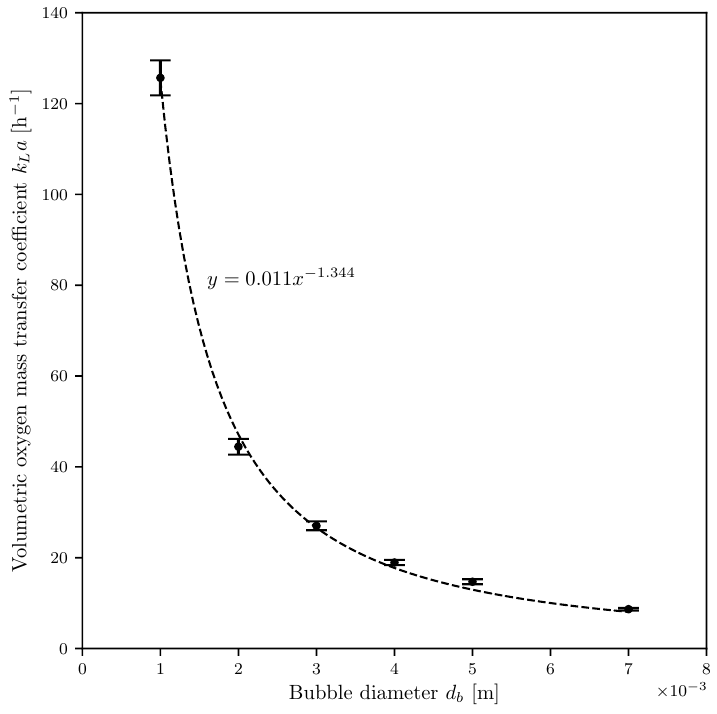
Figure 4. Influence of a constant bubble diameter on the k L a